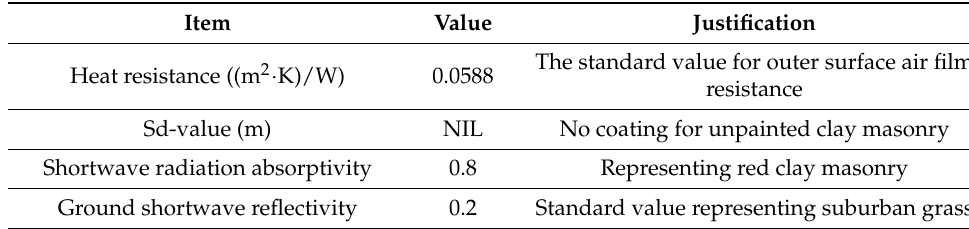
Table 7. User-defined settings of the exterior surface.